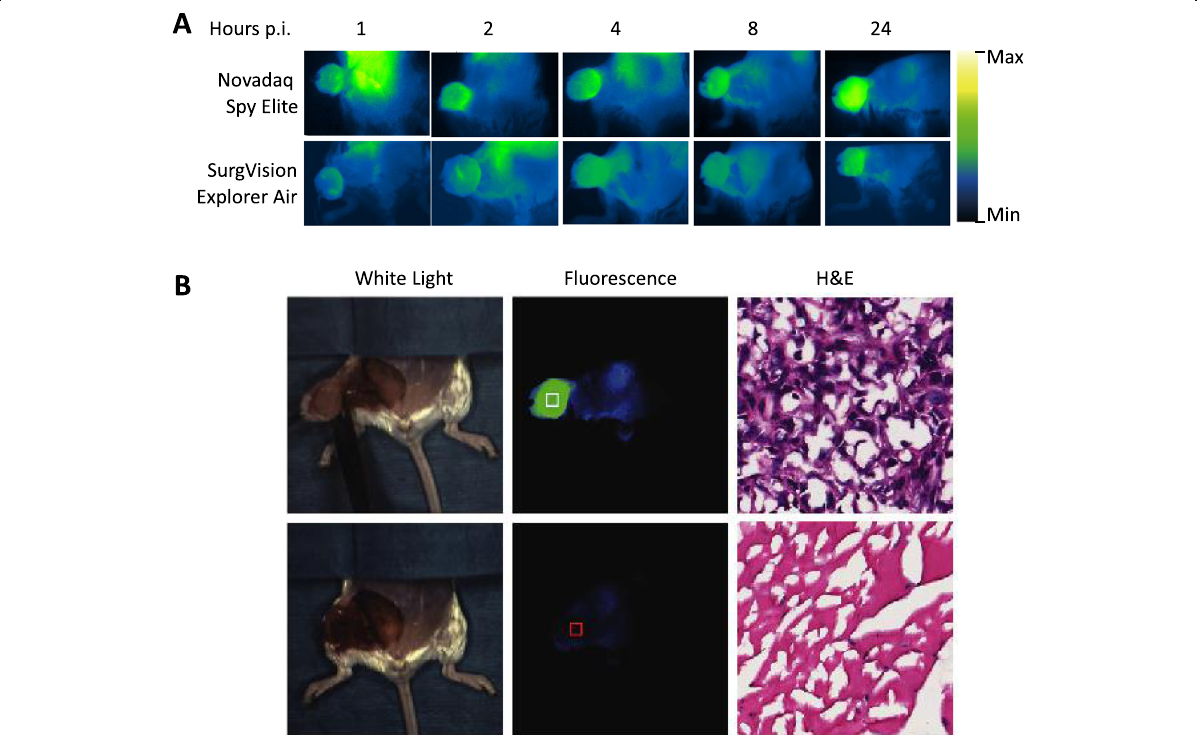
Fig. 5 Image-guided surgery post intravenous injection of VGT-309. a Still images from Novadaq Spy Elite and SurgVision Explorer Air during resection of 4T1 tumors on different time points after injection of VGT-309. b White light (left) and fluorescent (middle) images of the surgical field before (upper) and after (lower) tumor removal using the Novadaq Spy Elite. H&E staining (right) histopathological analysis confirms that the tissues highlighted in the white and red squares in the middle panels are breast tumor and muscle,